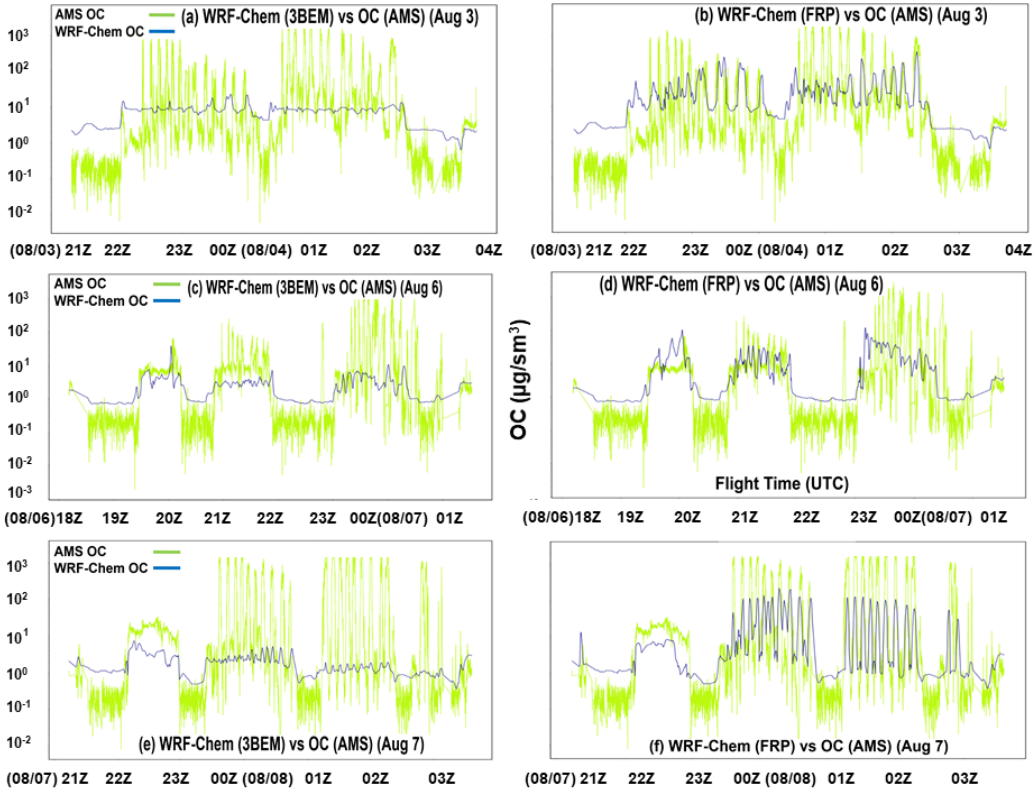
Figure 6. Time series for OC (AMS) in situ measurements and corresponding WRF-Chem-simulated BC (3BEM and FRP versions) for the 3 August (a, b) , 6 August (c, d) , and 7 August (e, f) DC-8 science